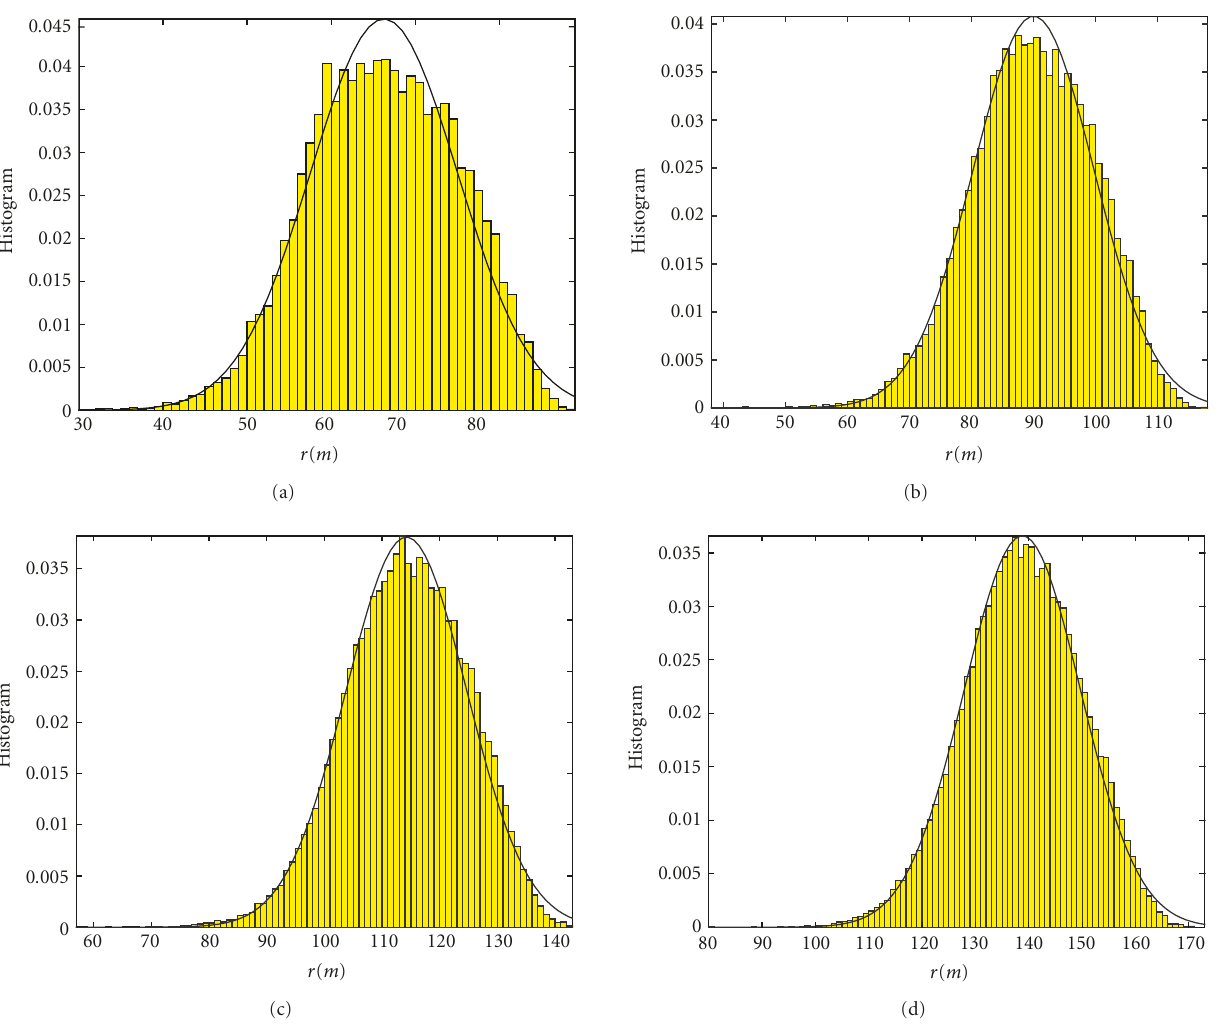
Figure 2: The histogram versus postulated distribution for end-to-end distances for given number of hops: (a) three hop; (b) four hop; (c) five hop; (d) six